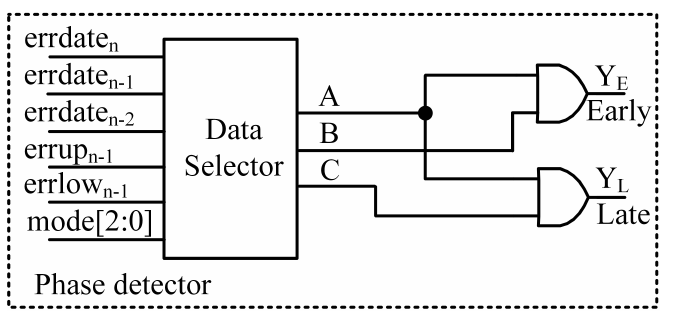
Figure 10. Logic gate circuit of Phase Detector.